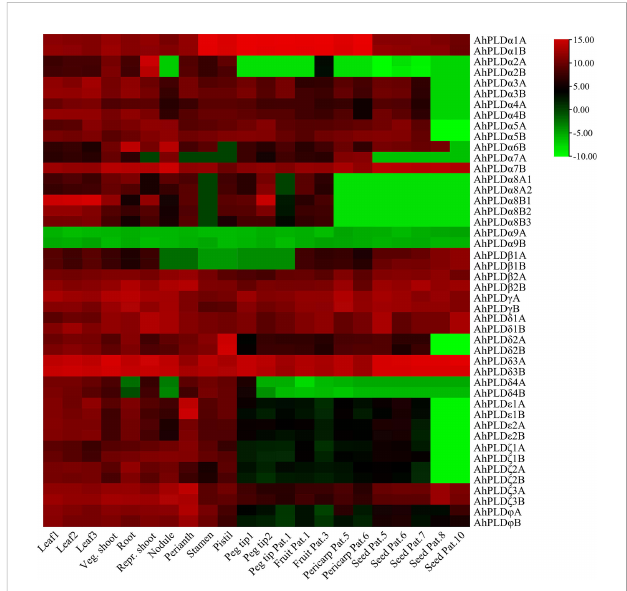
FIGURE 8 Expression pro fi les of 46 AhPLDs in 22 different tissues. The X axis represents various tissues. The Y axis represents 46 AhPLDs . The color scale represents Log2 expression values (FPKM).